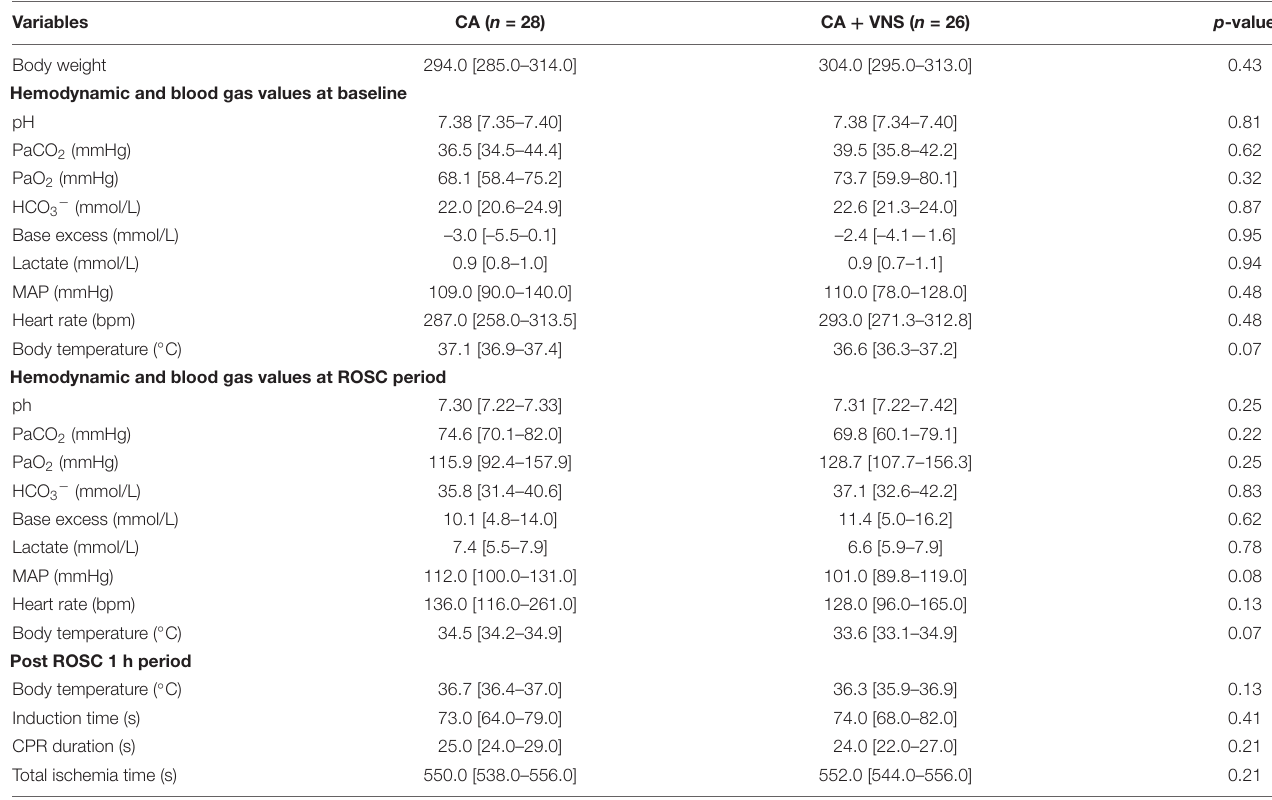
TABLE 1 | Comparison of hemodynamic and blood gas analysis